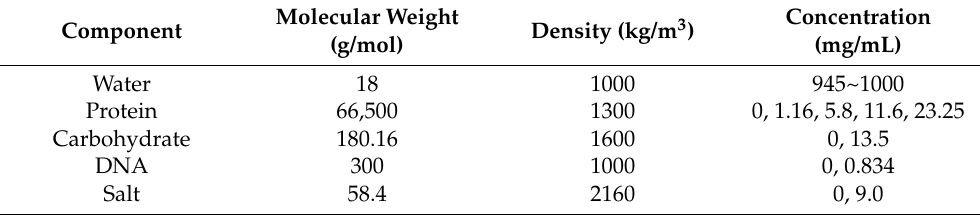
Table 1. Initial composition and volume fraction of aqueous solutions and molecular weights and densities of each constituent. The concentration of proteins in aqueous solutions varied from 0 to 23.25 mg/mL. The maximum concentrations of carbohydrates, DNA, and salt in aqueous solutions were 13.5 mg/mL, 0.834 mg/mL, and 9.0 mg/mL, respectively. The aqueous solutions were used to prepare the biofilms on steel